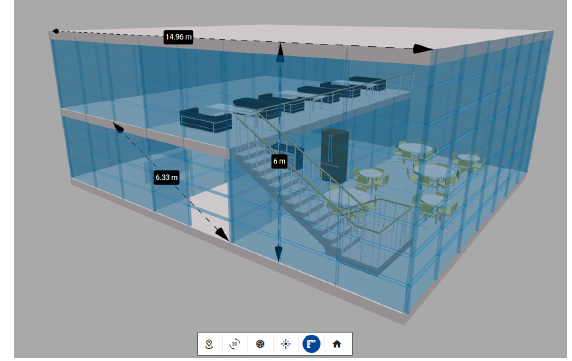
Figure 7. Taking measurements of an IFC